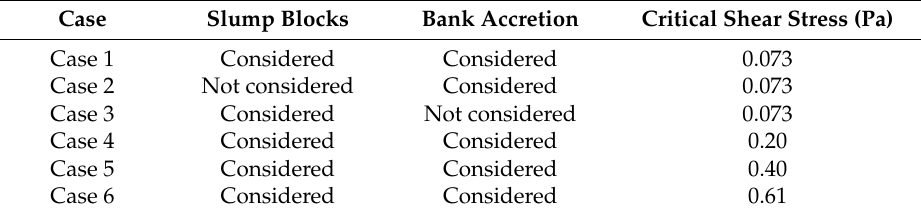
Table 2. Simulated cases for small scale.